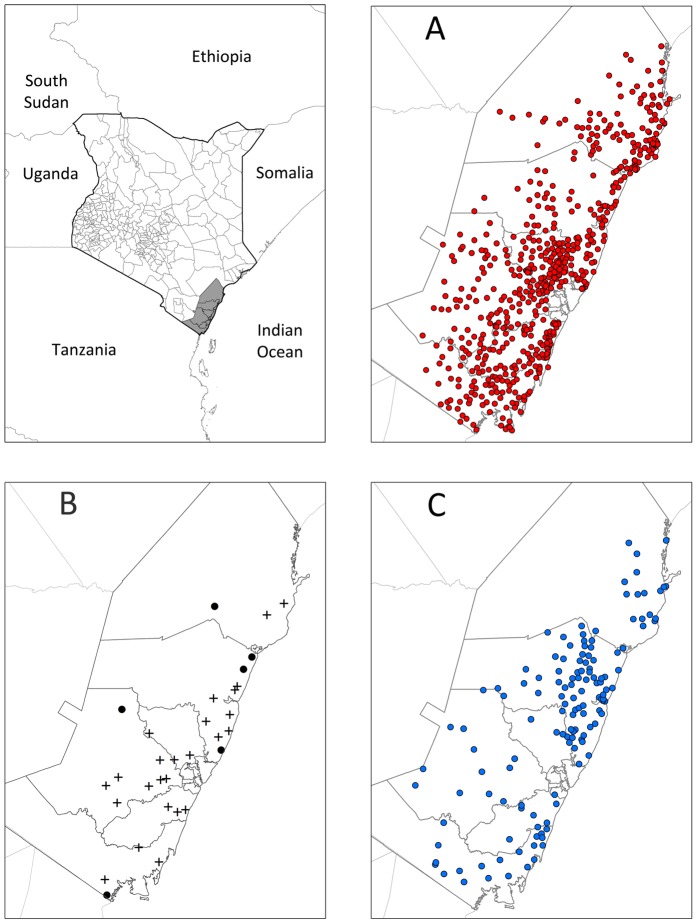
The location of the study districts (inset map) and schools (main map) in Kenya.(A) Locations of schools with questionnaire data, (B) Locations of schools with parasitological data (crosses show schools also with questionnaire data and circles represent schools with parasitological data only), and (C) Locations of schools with no data.